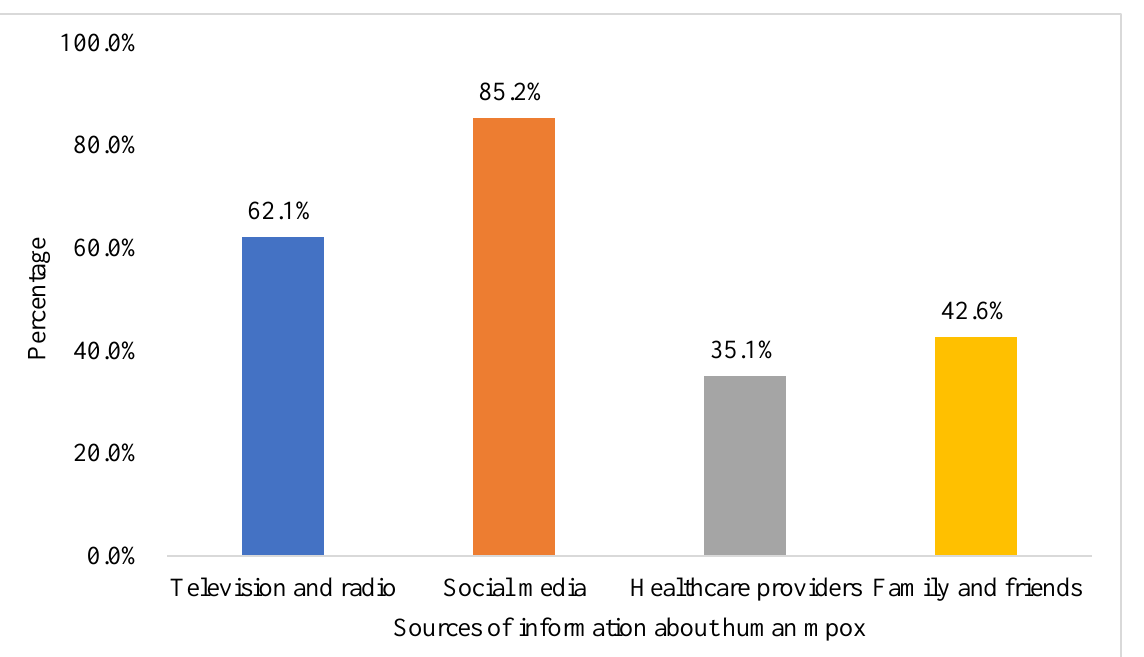
Figure 1. Sources of participants’ information about human mpox (n = 1195).